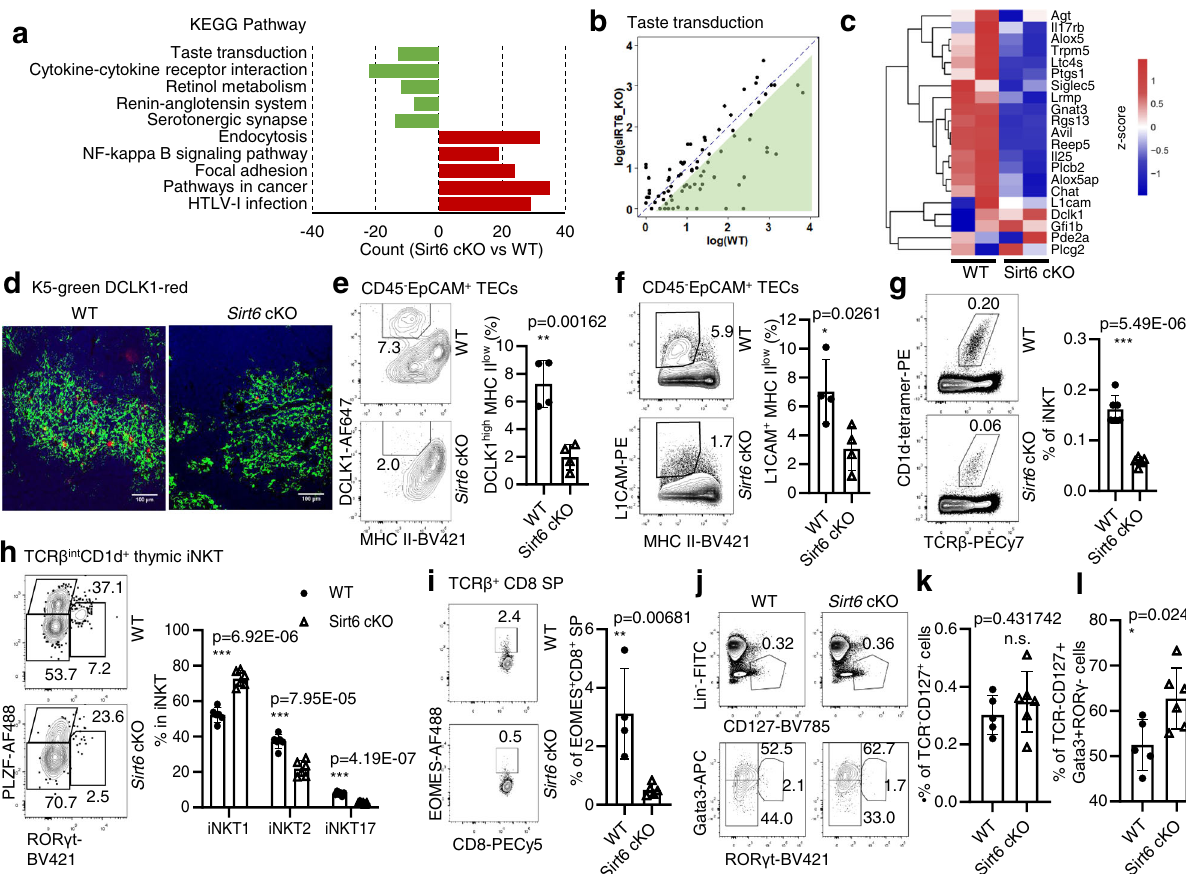
Fig. 4 Sirt6 deletion affects the cell number and function of thymic tuft cells. a Downregulated genes or upregulated genes in Sirt6 -de fi cient mTECs are enriched in KEGG pathways, and the top fi ve pathways are ordered by p value. All pathways were selected under the standard of p < 0.05. b Scatter plot shows the difference in TPM values of taste transduction genes between WT and Sirt6 -de fi cient mTECs. c Differential expression of thymic tuft cell-related genes between mTECs sorted from WT and Sirt6 cKO mice. The color scale indicates the level of gene expression. d Representative images of frozen thymic sections from WT and Sirt6 cKO mice ( n = 4 per group). Green, KRT5. Red, DCLK1. Scale bars: 100 μ m. e Representative fl ow cytometric pro fi les and frequency of thymic tuft cells (CD45 – EpCAM + MHCII low DCLK1 high ) obtained from 4-week-old Sirt6 cKO mice and littermates ( n = 4 per group). f Representative fl ow cytometric pro fi les and frequency of L1CAM + thymic tuft cells from 4-week-old Sirt6 cKO mice and littermates ( n = 4 per group). g Representative fl ow cytometric plots and frequency of TCR β int CD1d + thymic iNKT cells in 4-week-old Sirt6 cKO mice and littermates ( n = 6 per group). h Representative fl ow cytometric plots and frequencies of NKT1 (PLZF – ROR γ t – ), NKT2 (PLZF + ROR γ t – ), and NKT17 (PLZF – ROR γ t + ) in 4-week-old Sirt6 cKO mice and littermates ( n = 6 per group). i Representative fl ow cytometric plots and frequency of EOMES + TCR β + CD8 single-positive thymocytes in 4- week-old WT ( n = 4) and Sirt6 cKO ( n = 5) mice. j Representative fl ow cytometric plots of Lin – TCR – CD127 + thymic ILCs (upper) and ILC subsets (lower) in Sirt6 cKO mice and littermates. k , l Frequencies of Lin – TCR – CD127 + thymic ILCs ( k ) and Lin – TCR – CD127 + Gata3 + Ror γ t – ILC2s ( l ) of WT ( n = 5) and Sirt6 cKO ( n = 6) mice. * p < 0.05, ** p < 0.01 and *** p < 0.001 compared with the identical WT control mice (Student ’ s t -test). The error bar represents one standard